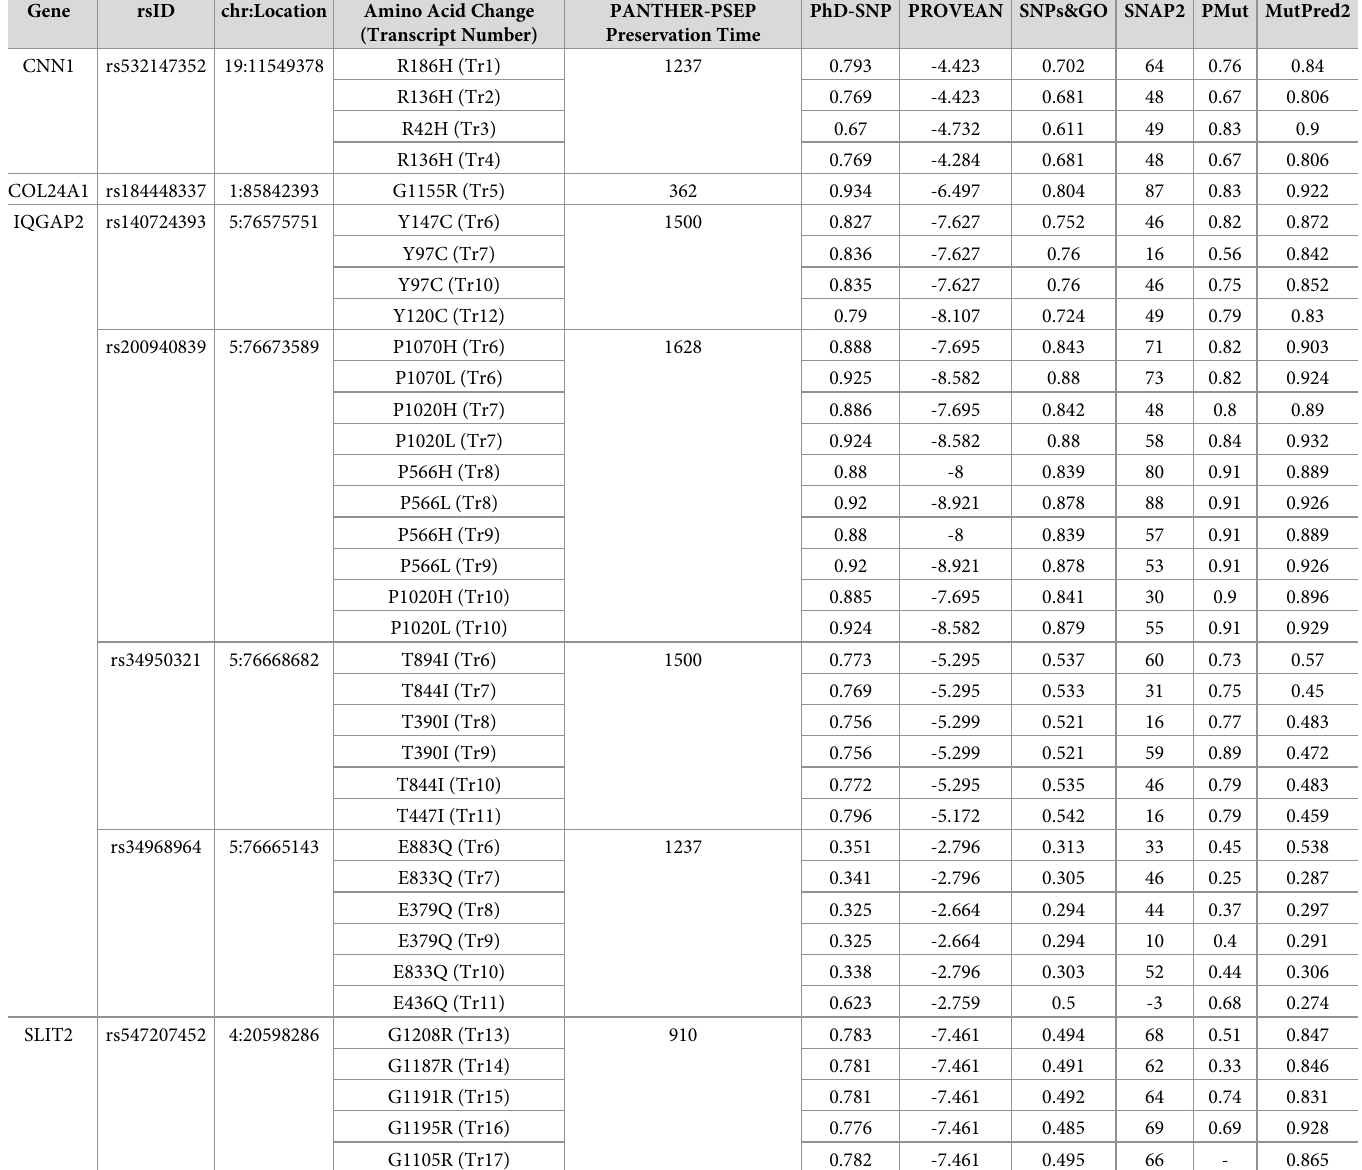
Table 3. Transcript sequence-based functional impact analyses of rare nsSNPs of PTB-related genes. Gene rsID chr:Location Amino Acid Change PANTHER-PSEP (Transcript Number) Preservation